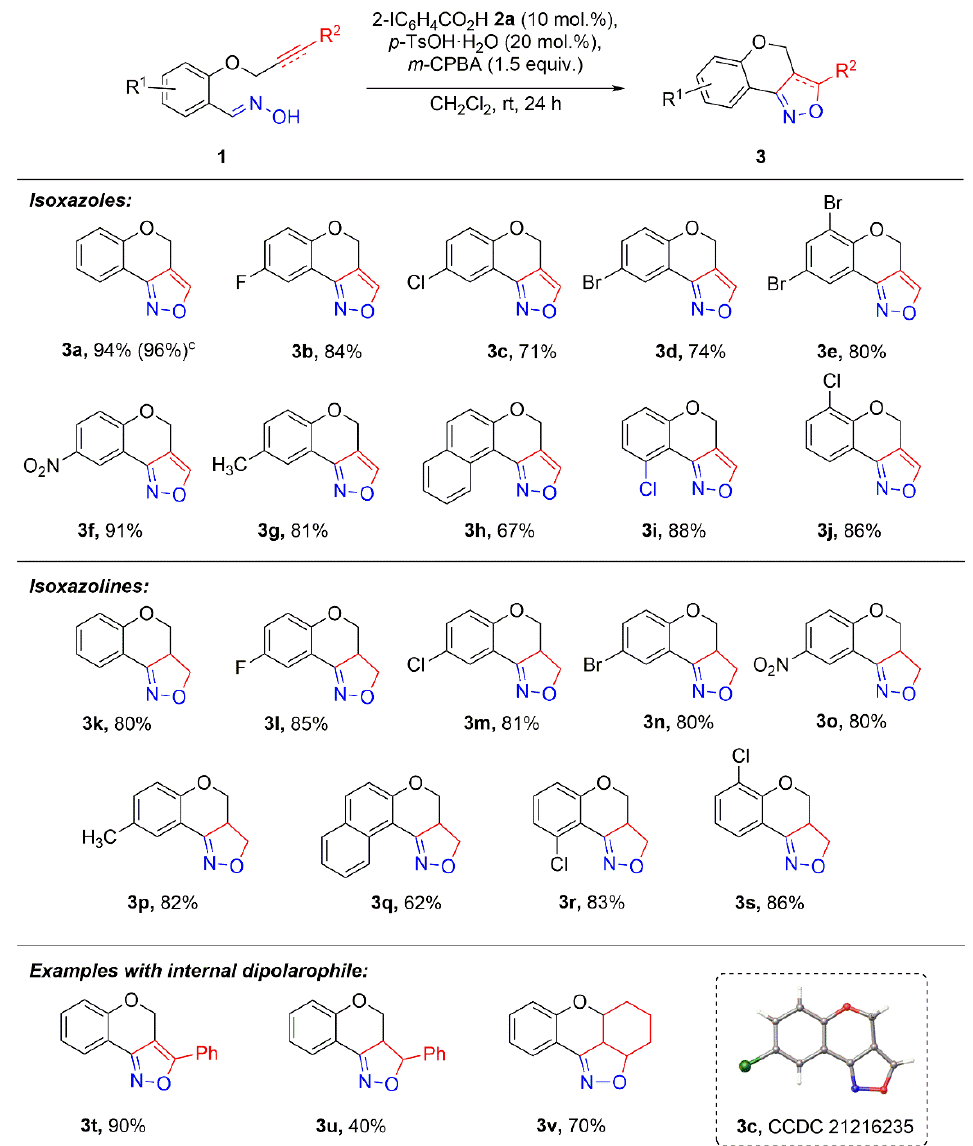
Figure 2. Catalytic intramolecular cycloaddition of aldoximes 1 a,b . a Reaction conditions: Aldoxime 1 (0.20 mmol, 1 equiv.), 2a (10 mol%) and p -toluenesulfonic acid (20 mol%) with m -CPBA (0.30 mmol, 1.5 equiv.) stirred in dichloromethane (2 mL) at room temperature for 24 h. b Isolated yields of 3